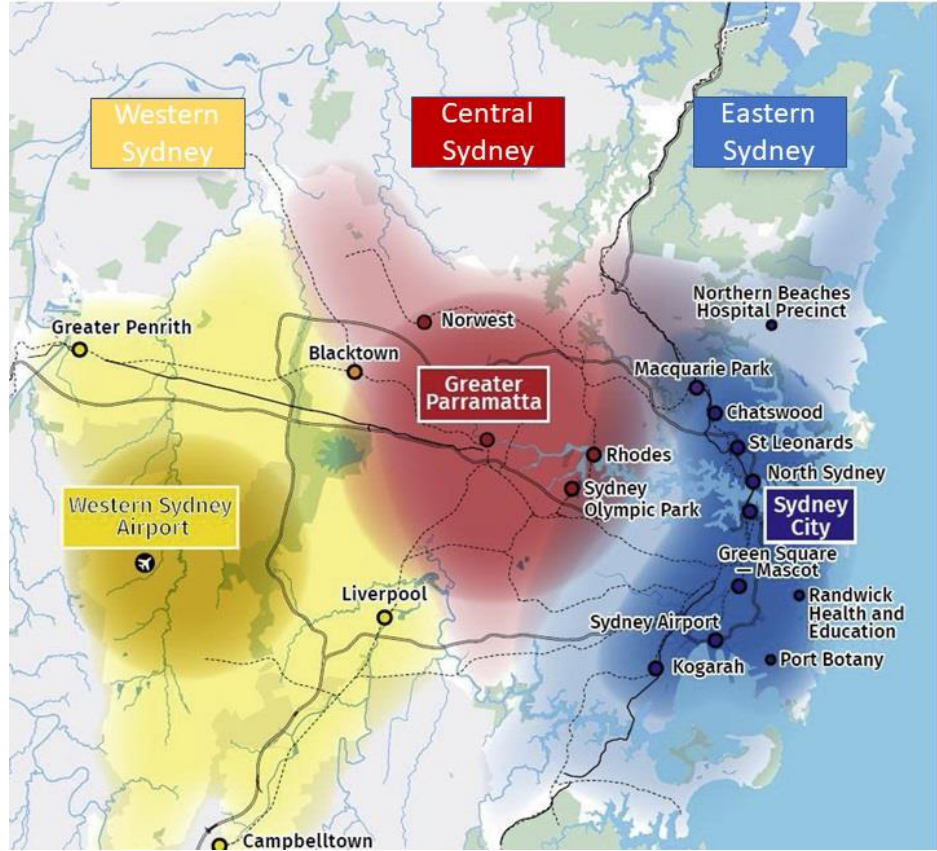
Figure 1. The Greater Sydney area: A metropolis of three cities.